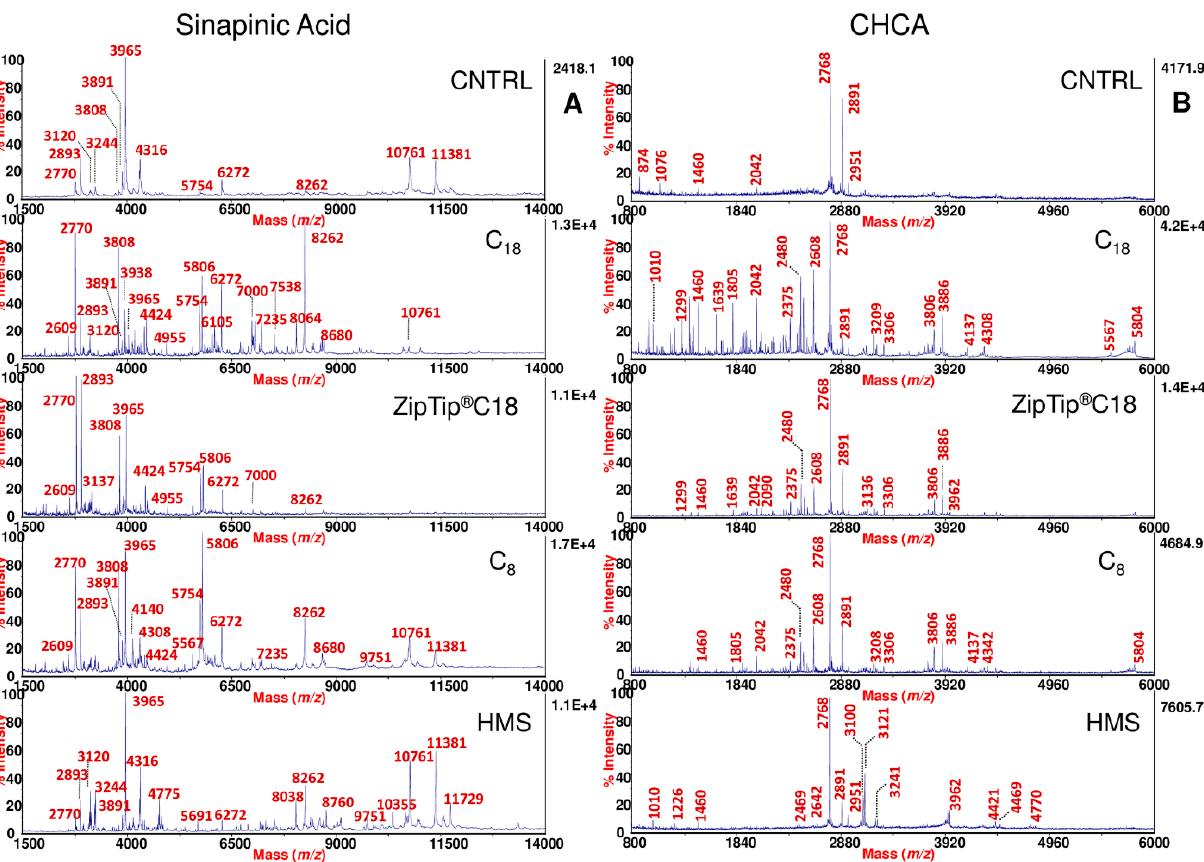
Figure 1. MALDI-TOF MS full view of SP using SA and CHCA matrices. MALDI-TOF mass spectra of SP obtained from the same fertile normozoospermic man using SA ( A ) and CHCA ( B ) as matrix, before and after processing by C 18 , ZipTip ® C18, C 8 , and HMS. For SA, the spectra are shown in the m / z range from 1500 to 14,000. For CHCA, the spectra are shown in the m / z range from 800 to 6000, with labeled monoisotopic